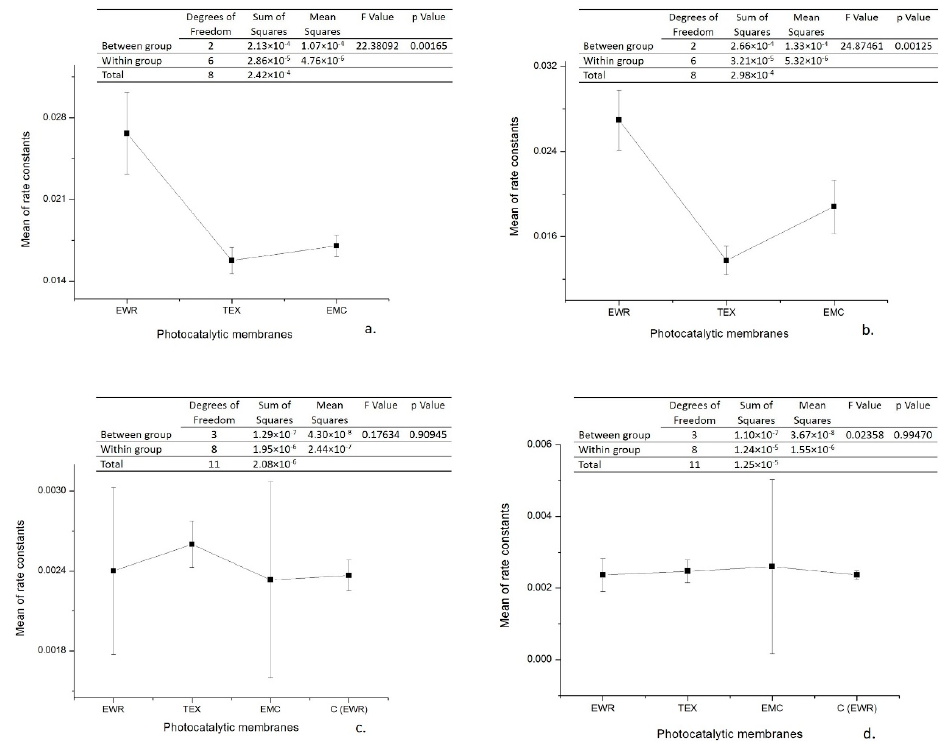
Figure 5. One-way analysis of variance (ANOVA) test results (significance level: α = 0.05): ( a ) irradiation interval 0–30 min (Cycle I); ( b ) irradiation interval 0–30 min (Cycle II); ( c ) irradiation interval 30–120 min (Cycle I); ( d ) irradiation interval 30–120 min (Cycle